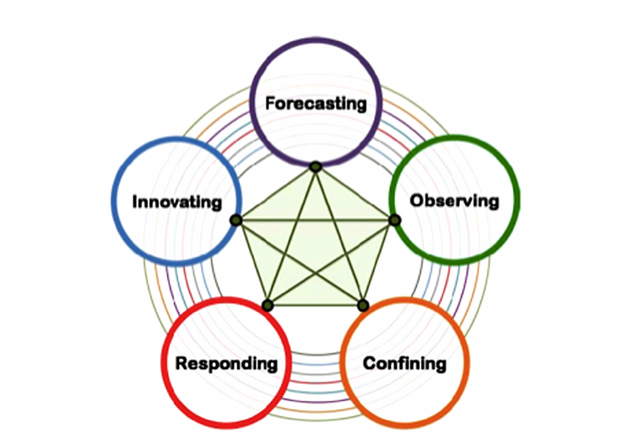
Figure 1. Schematic of grand challenges from the “Earth System Science for Global Sustainability”. Source: ICSU